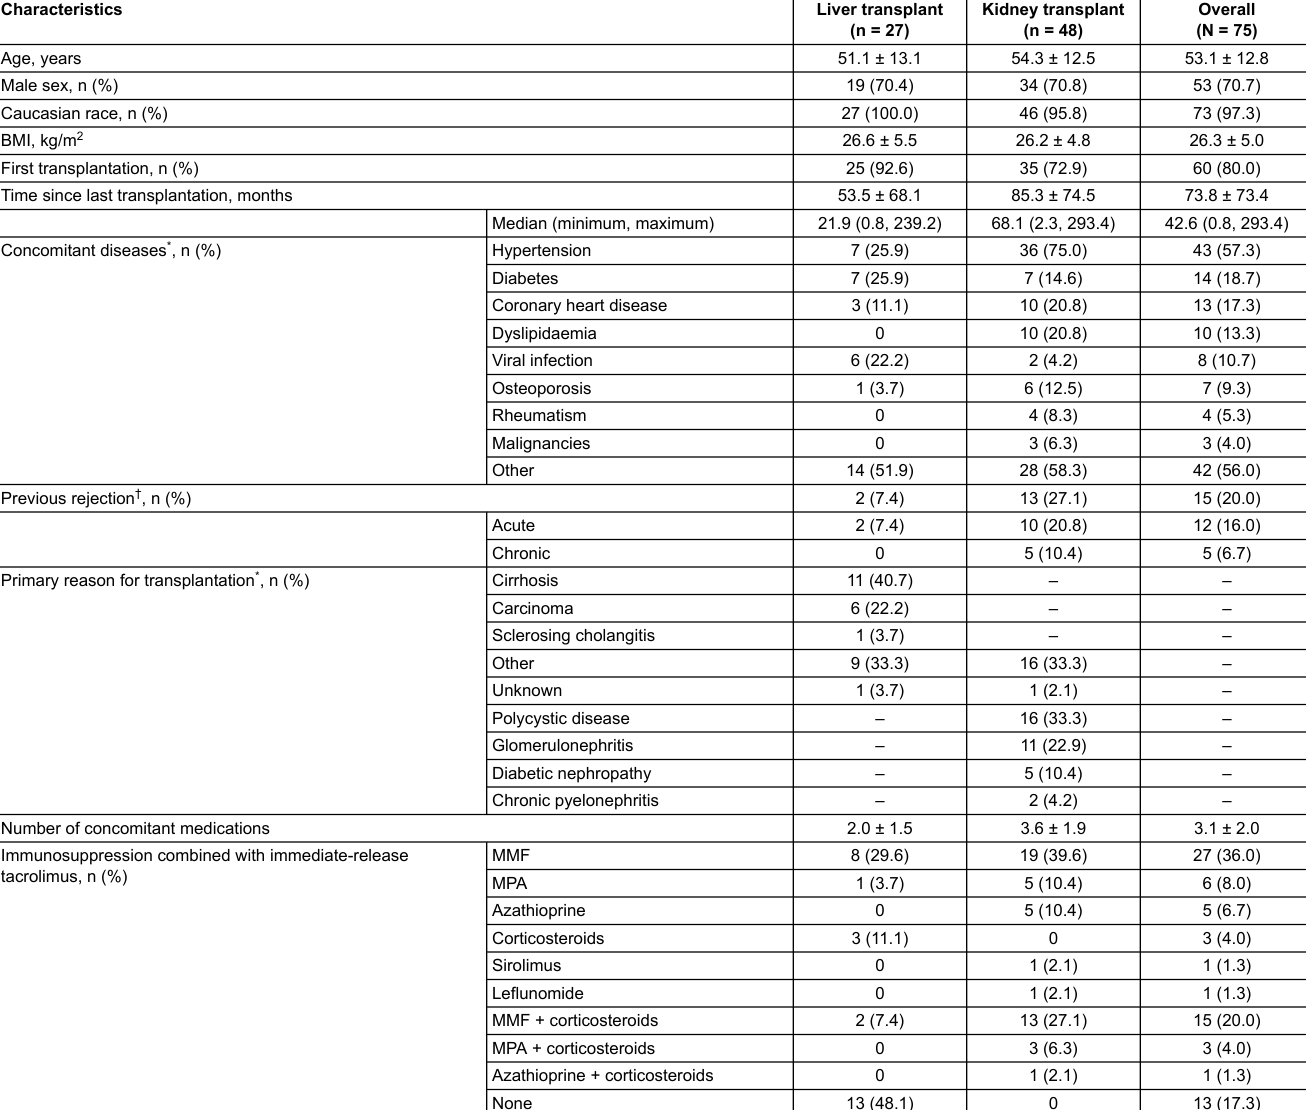
Table 2: Patient demographics and baseline characteristics, stratified by transplanted organ and overall (full analysis set).